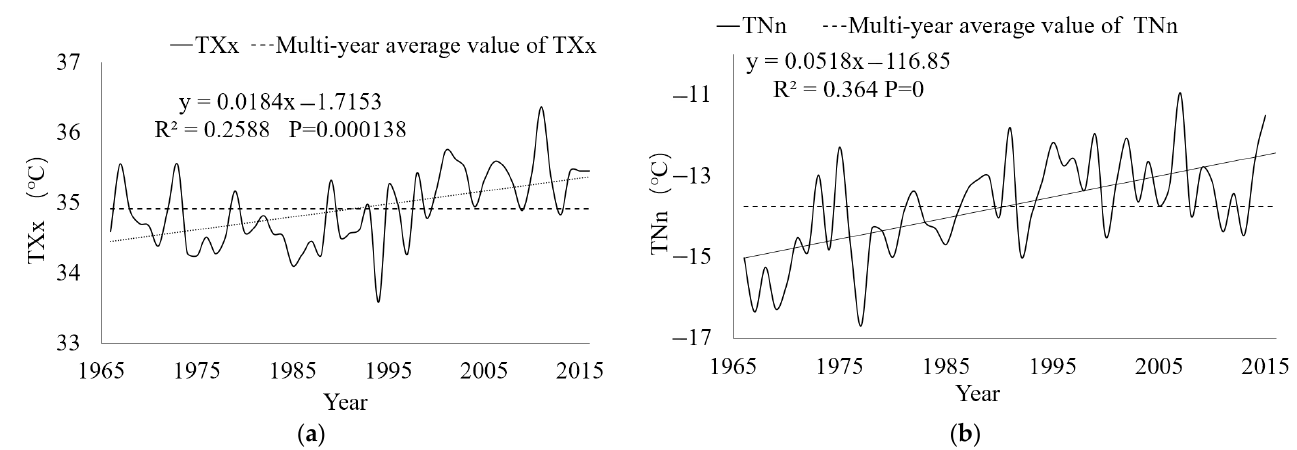
Figure 4. Temporal variation of TXx and TNn in China from 1966 to 2015. ( a ) TXx. ( b ) TNn.